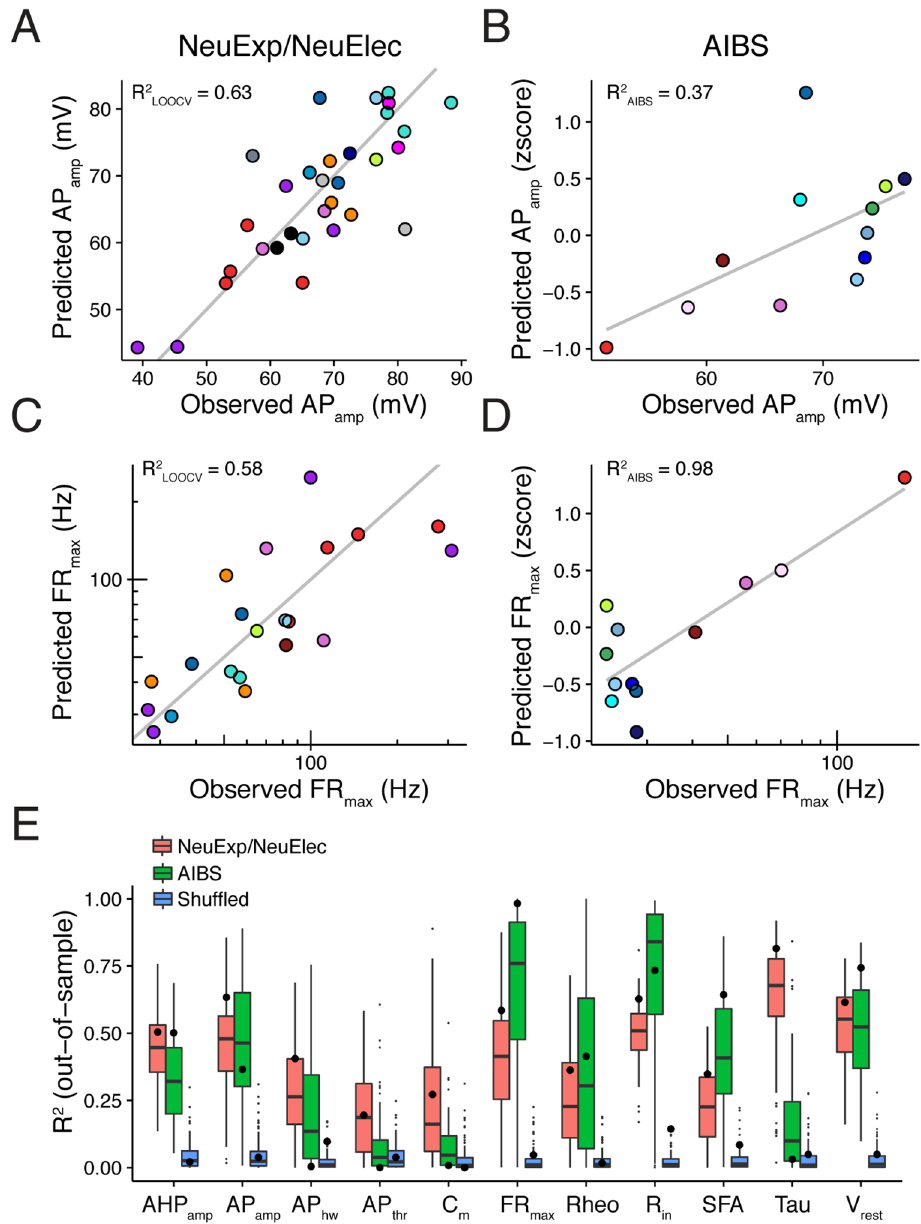
Fig 3. Multivariate gene expressioncan predict cell type-specific electrophysiological parameters. A) Comparison of observed action potentialamplitudes (AP amp ; x-axis) to predicted values (y-axis) using gene expression-basedstatistical models trained using the NeuroExpresso/NeuroElectro discovery dataset. The y- value of each point (a cell type) is basedon leave-one-out cross-validation (LOOCV). R 2 LOOCV indicatesthe calculatedR 2 across the set of cell type predictionsand grey line indicatesthe unity line. B) Same as A, but observedand predictedvalues are basedon the AIBS validationdataset. Ephys predictionson y-axis are made by applyingthe discovery dataset-based models (as in A) to the AIBS-dataset multivariate gene expressionprofiles. R 2 AIBS is calculatedacross the set of predictions made for the AIBS cell types and grey line indicatesbest linear fit. C,D) Same as A and B, but for maximum firing rate (FR max ). E) Summarized performance of gene expression-basedstatistical models for predictingephys parameters. Large dots indicatethe R 2 LOOCV from the NeuExp/NeuElec discovery dataset (pink), R 2 AIBS values from the validation dataset (green), and R 2 LOOCV values on a versionof the NeuExp/NeuElec discovery dataset where cell type labelswere randomlyshuffled (blue). Boxplots are basedon 100 bootstrap resamples of the discovery dataset and small dots